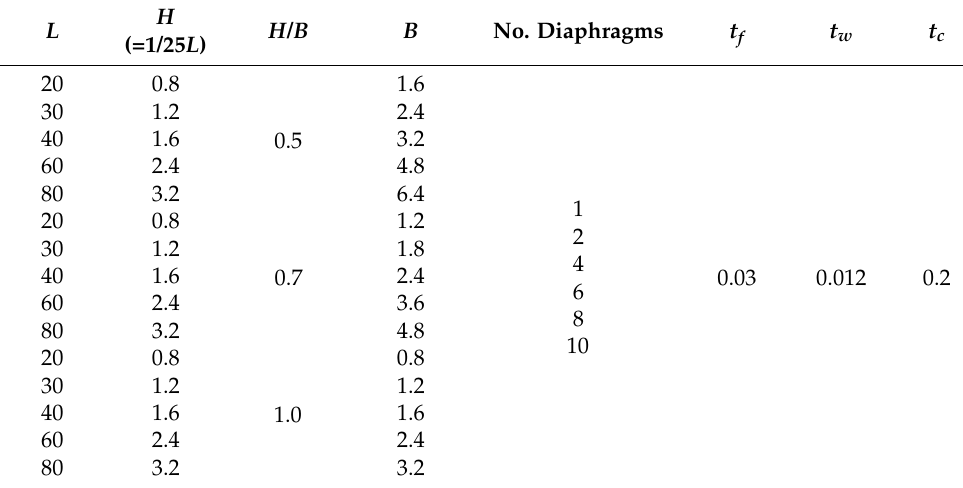
Table 2. Dimensions of the box girder models for the FEA (unit: m).